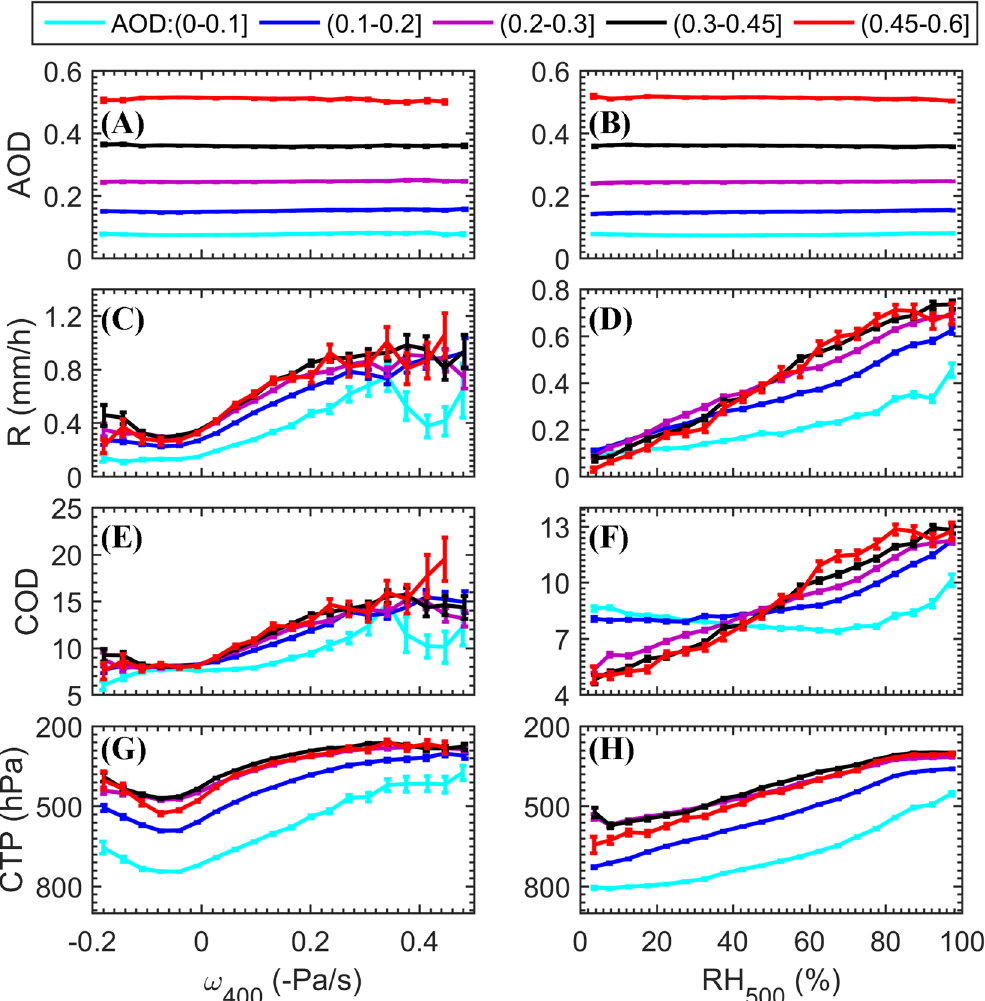
Figure 2. AOD and cloud properties as a function of two meteorological parameters for five AOD levels, over the ROI at 1330 local time in JJA (2003–2012). ( A ) AOD versus ω 400 (bin size of 0.14 Pa/s), ( B ) AOD versus RH 500 (bin size of 5%), ( C ) R versus ω 400 , ( D ) R versus RH 500 , ( E ) COD versus ω 400 , ( F ) COD versus RH 500 , ( G ) CTP versus ω 400 , and ( H ) CTP versus RH 500 . The error bars represent standard